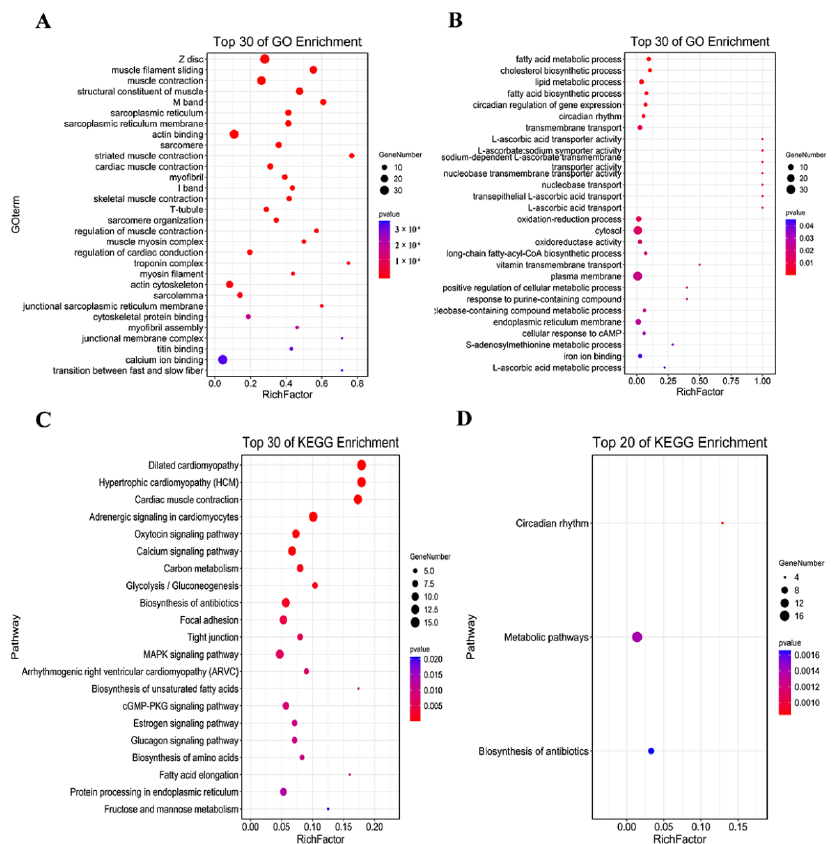
Figure 5. GO enrichment analysis of ( A ) highly expressed and ( B ) little-expressed DEGs for HSYA delay of LA. KEGG enrichment analysis of ( C ) highly expressed and ( D ) little-expressed DEGs for HSYA delay of LA. p <0.05.